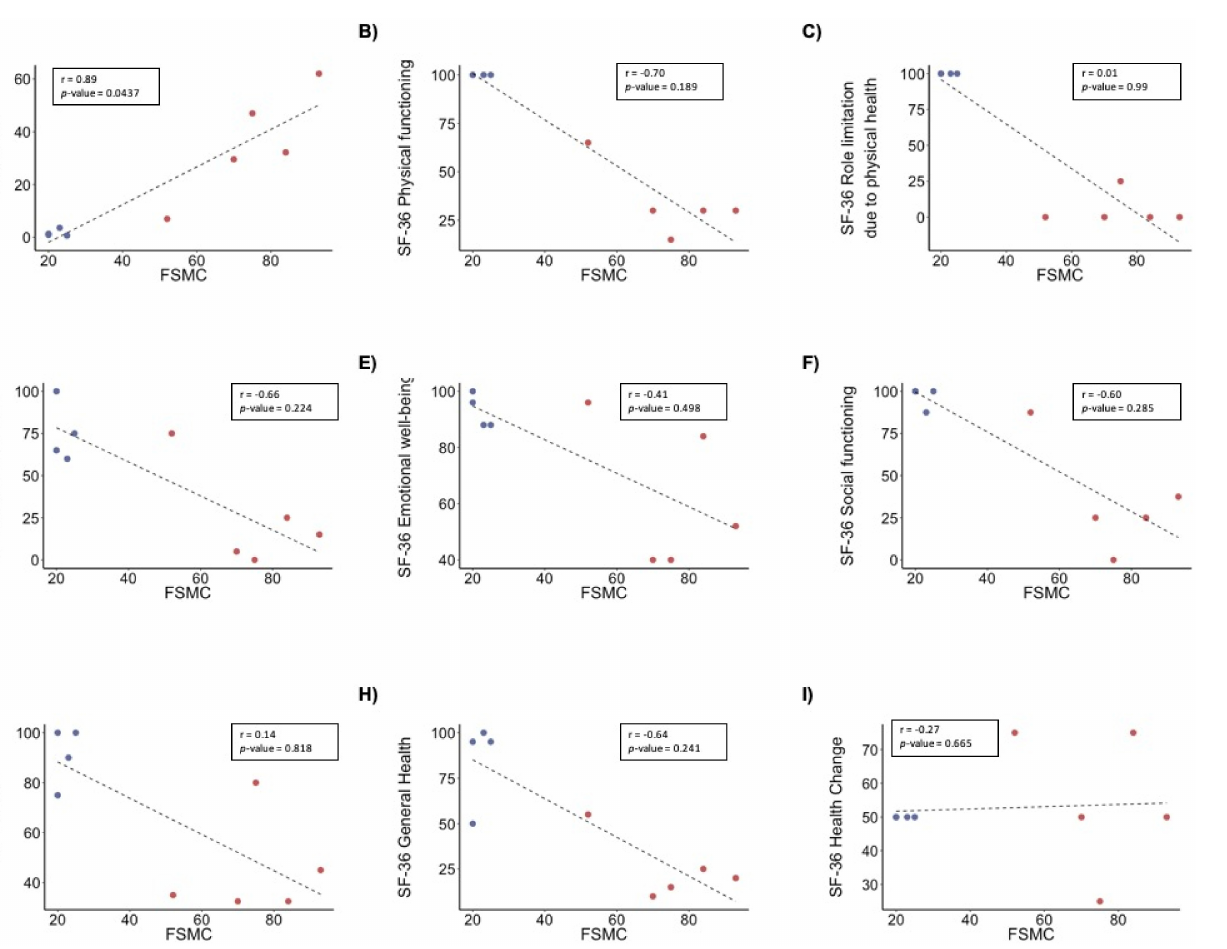
Figure 1. Correlation analyses of self-assessed fatigue in ME/CFS patients and controls. Pearson correlation analysis of FSCM total score with: ( A ) compass-31, ( B ) SF-36 physical functioning, ( C ) SF-36 role limitation due to physical health, ( D ) SF-36 energy and fatigue, ( E ) SF-36 emotional well-being, ( F ) SF-36 social functioning, ( G ) SF-36 pain, ( H ) SF-36 general health, and ( I ) SF-36 health change. p-values and Pearson (r) values were generated using Pearson’s correlation analysis. n = 10 (4 controls, 6 ME/CFS patients). Blue dots, controls; red dots, ME/CFS patients. n = 9 (4 controls, 5 ME/CFS